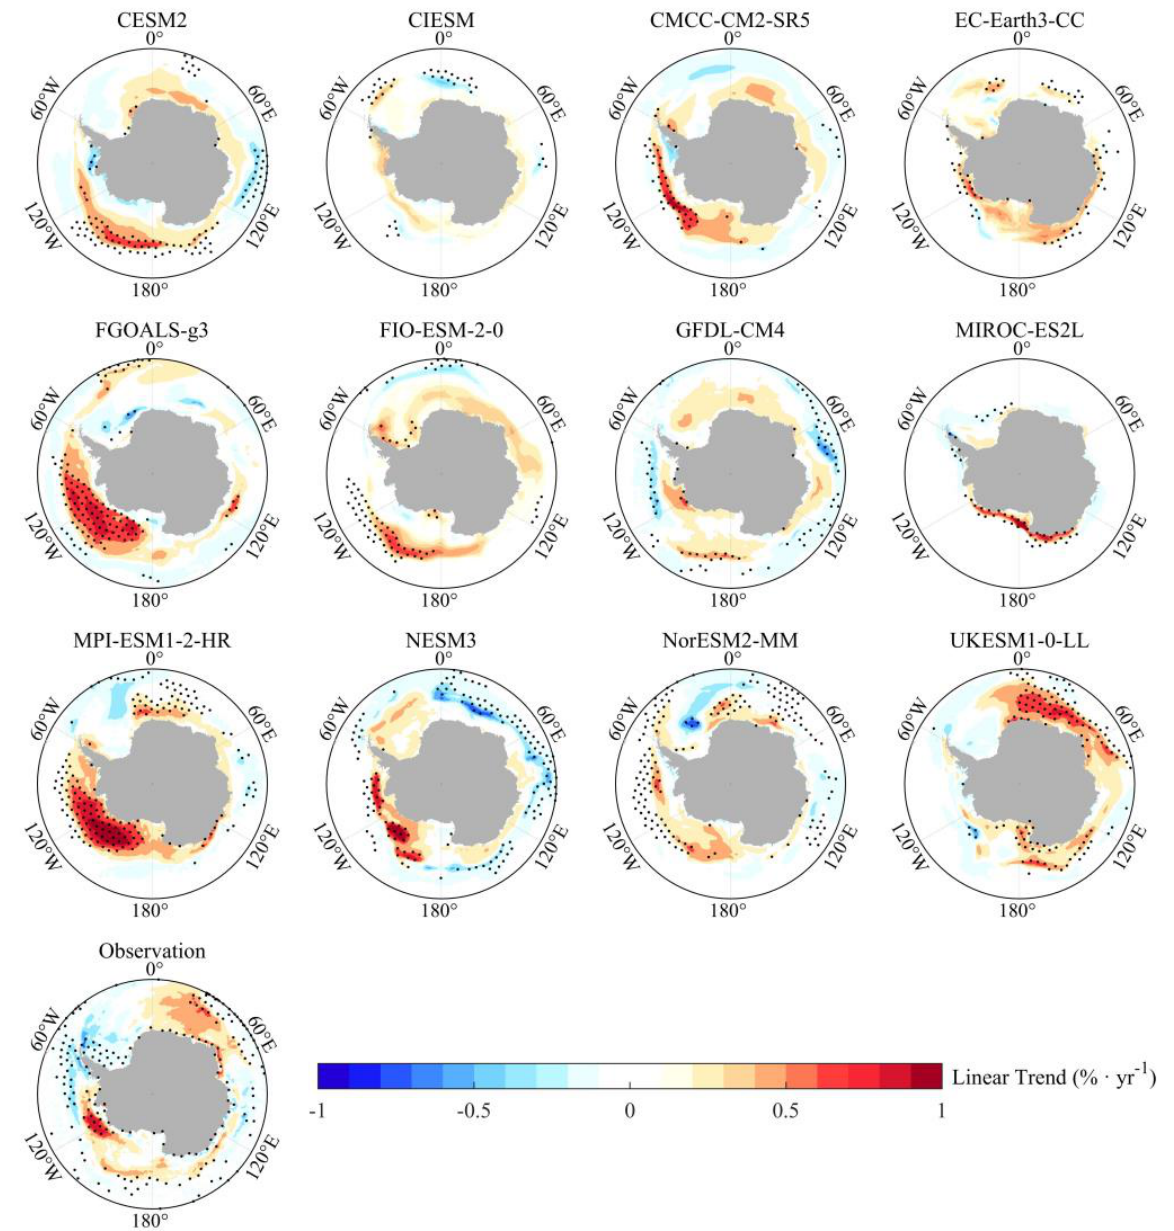
Figure 13. Linear trends of SIC for the CMIP6 models and the observation. The black dots indicate the regression slopes at the 95% confidence level.